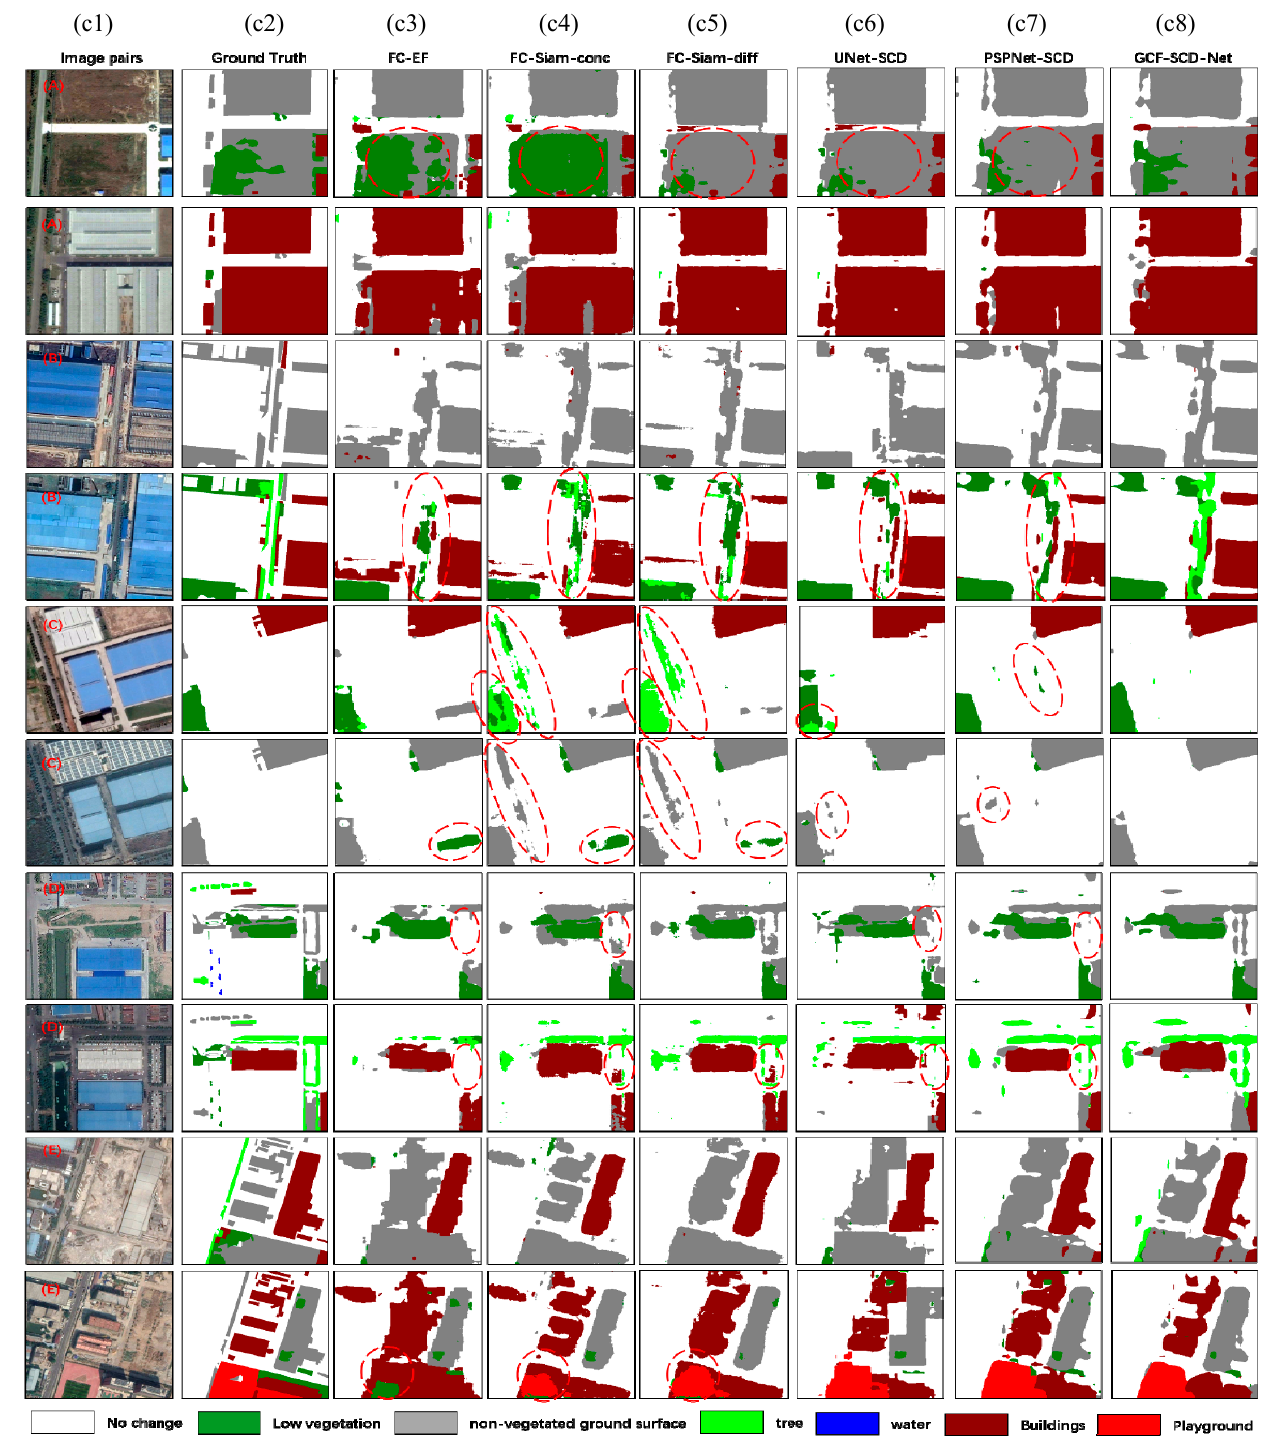
Figure 3. Comparisons with state-of-the-art methods on the SECOND dataset. c1 and c2 represent image pairs and ground truth, respectively; from c3 to c8 are the semantic segmentation results obtained by various change detection methods. ( A ),( B ),( C ),( D ),( E ) are the image pairs. ( A – E ) are the image